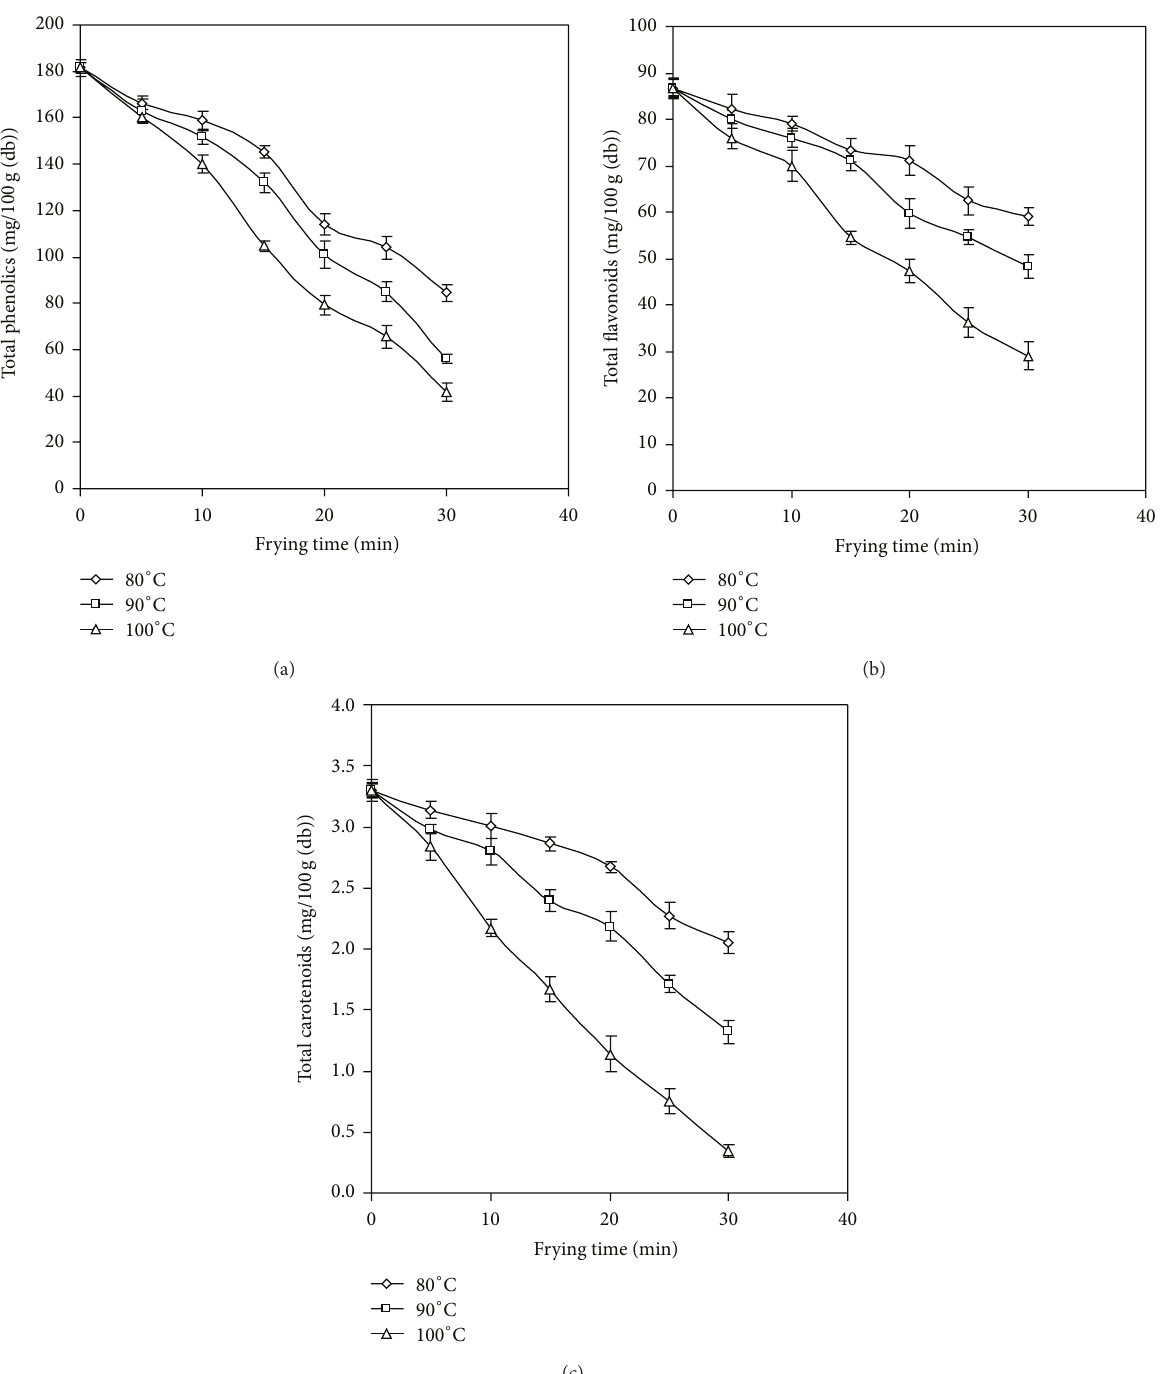
Figure 4: Changes in (a) total phenolics; (b) total flavonoids; and (c) total carotenoids in jackfruit chips during